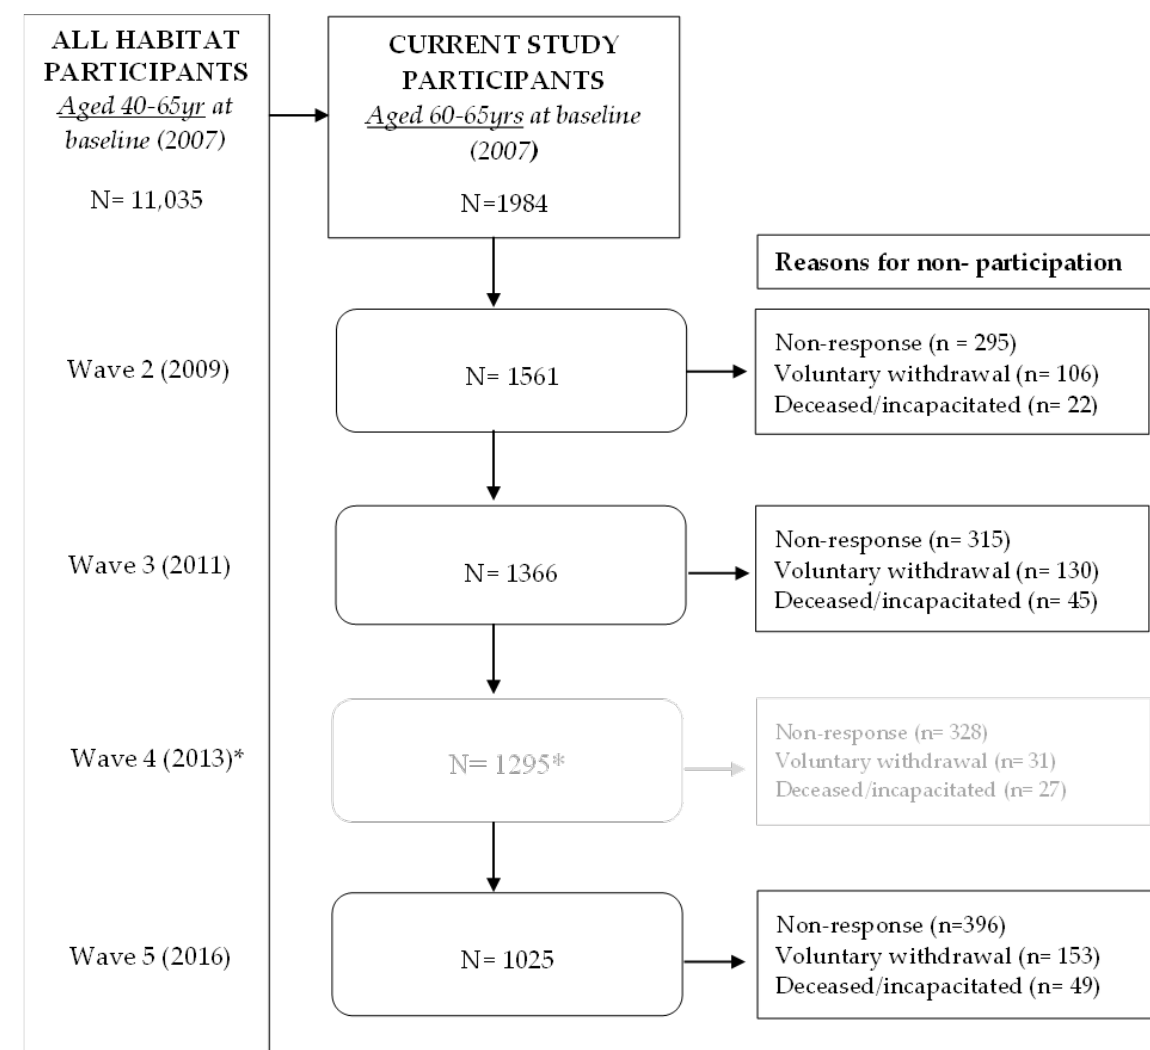
Figure 1. Flow of HABITAT participants aged 60–65 years at baseline over the 9 years of study. Note: Non-response are participants who did not return a survey or were not available at that time point (e.g., travelling overseas), but may have responded at subsequent time points. * Wave 4 (2013) was not used in this analysis, as social support for physical activity (SSPA) was not measured at this time point. Participant numbers are provided to describe the flow from Wave 3 to 5 and the derivation of the final analytic sample.